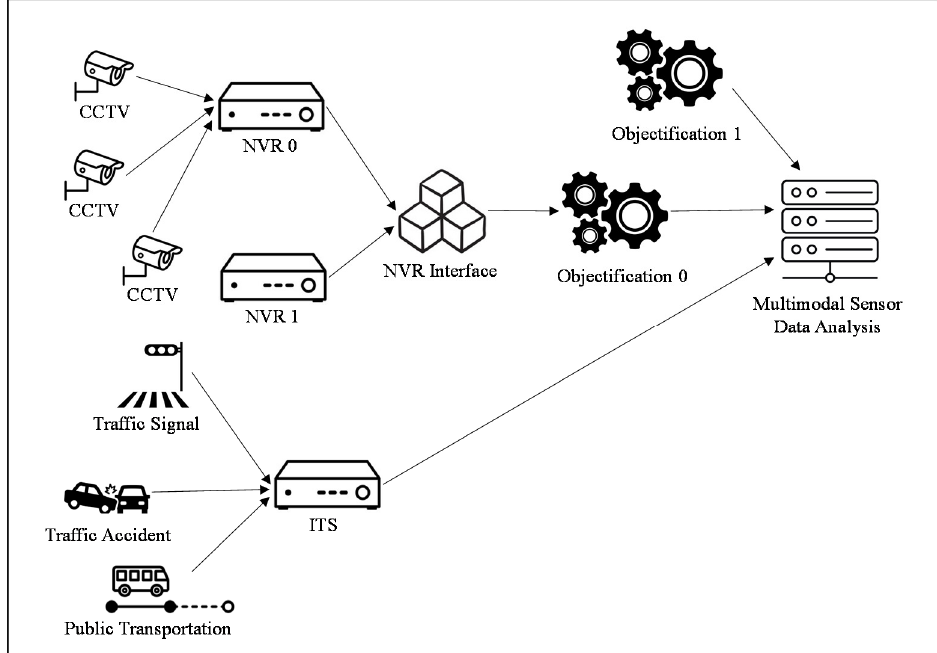
Figure 7. Image-based multimodal sensor data objectification and analysis.